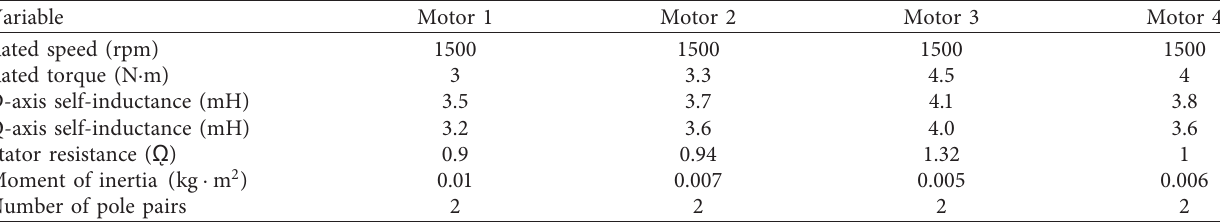
Table 3: 4 motor mechanical parameters.